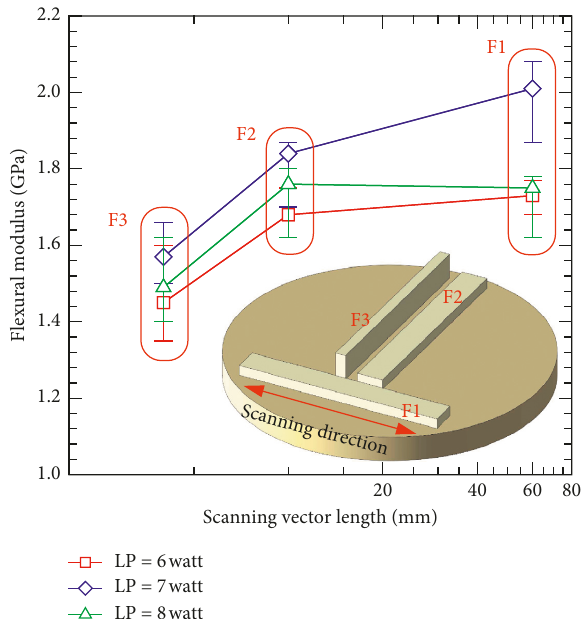
Figure 7: Effect of scanning vector length on the average flexural modulus of PA12/white cement composite.